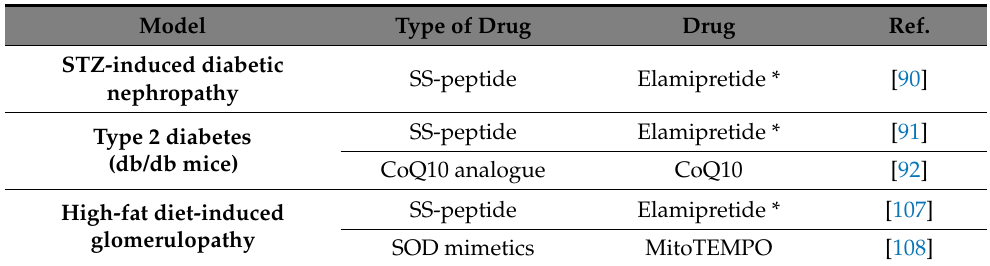
Table 2. Drugs targeting mitochondrial ROS that have shown beneficial effects in experimental CKD.